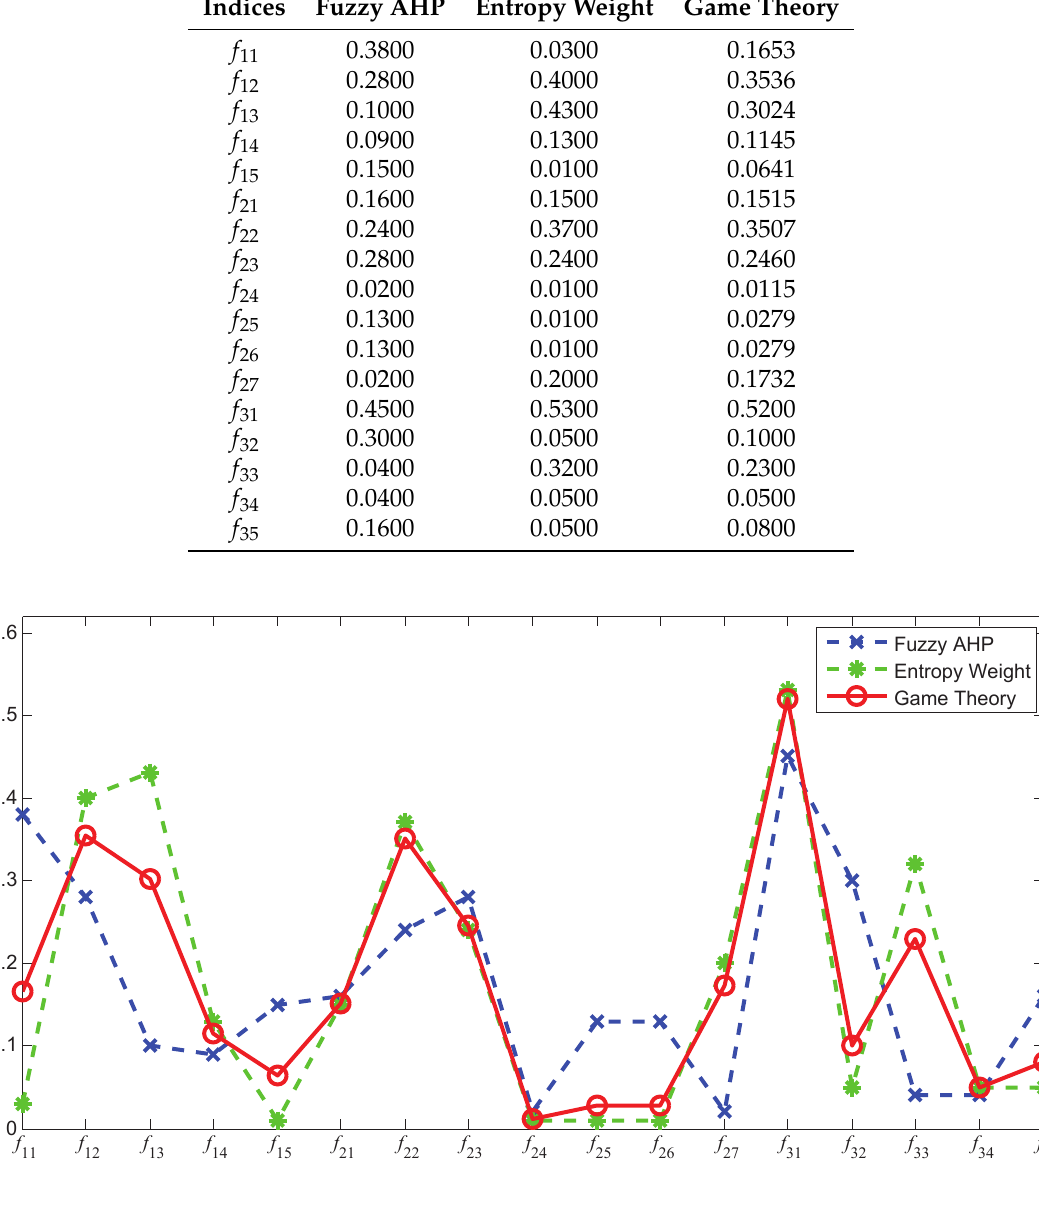
Figure 6. The calculation method of